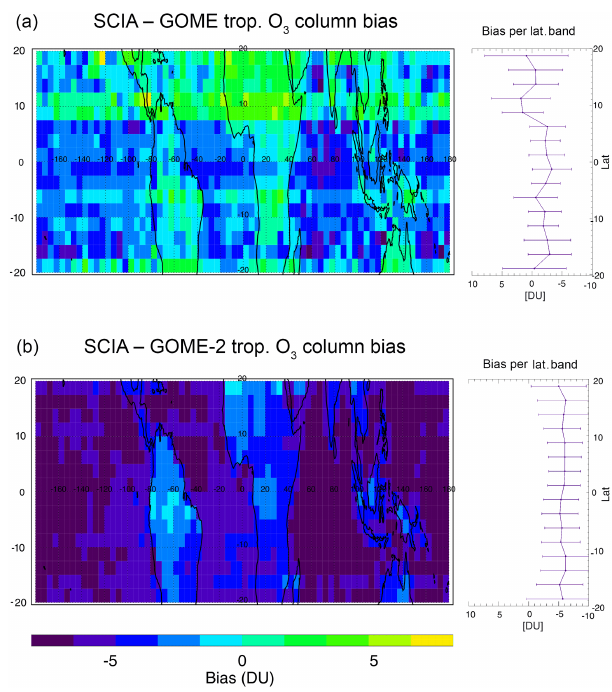
Figure 1. Correction offsets using SCIAMACHY TTCO as refer- ence. (a) Correction offset for GOME: average difference of GOME from SCIAMACHY TTCO for the years 2002–2003. (b) Correction offset for GOME-2: average difference of GOME-2 from SCIA- MACHY TTCO (in DU) for the years 2007–2012. On the right are shown the biases per latitude band. The error bars denote the 1 σ standard deviations of the latitudinally averaged